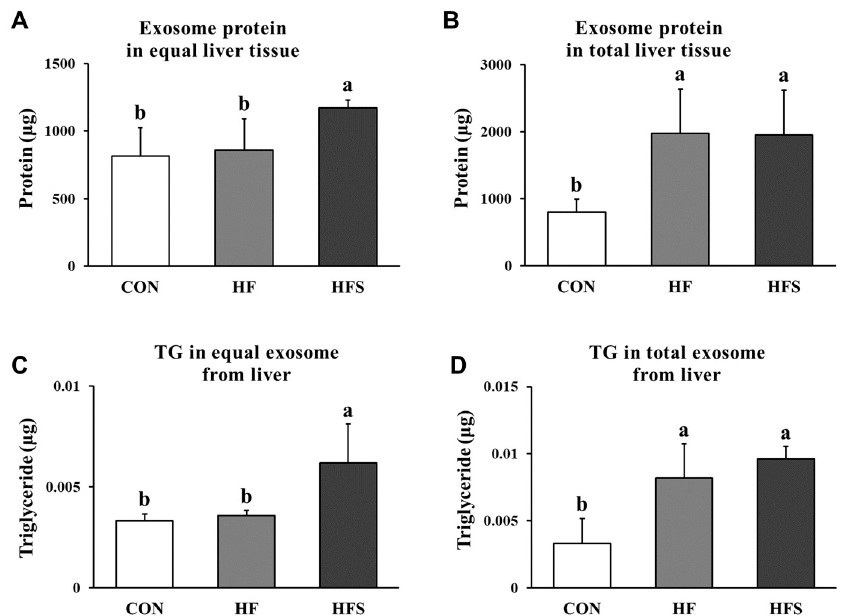
Figure 5. Protein content of liver-derived exosomes in livers of equal weight ( A ) and total liver weight ( B ) for mice and TG levels of liver-derived exosomes in equal amounts of exosomes ( C ) and total exosomes ( D ). C57BL/6J mice were fed an AIN-93G (CON), high-fat (HF; AIN-93G with 60 kcal% fat), or high-fat diet with 10% sucrose water (HFS) for 12 weeks. All data are expressed as the mean ± standard deviation. Different letters (a > b) indicate a significant difference among treatments. Multiple comparisons of means were performed using Duncan’s multiple range test at the 0.05 significance level ( n = 8). TG, triglyceride.